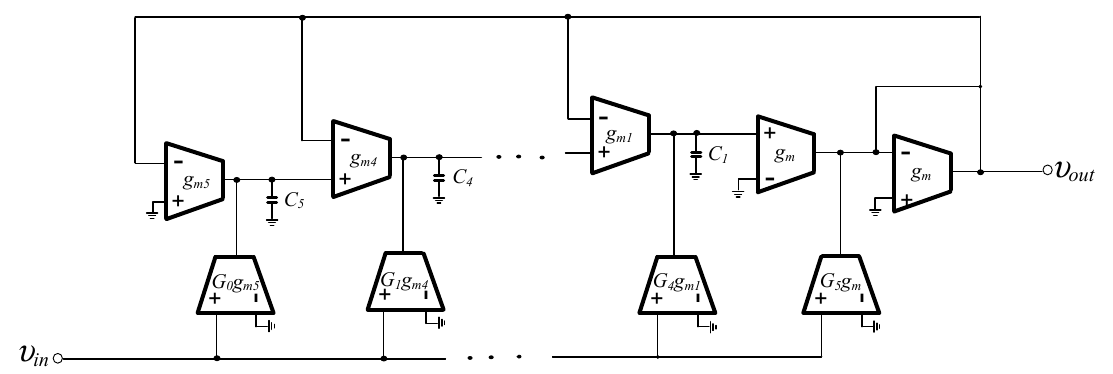
Figure 4. OTA-C realization of the fractional-order differentiator.